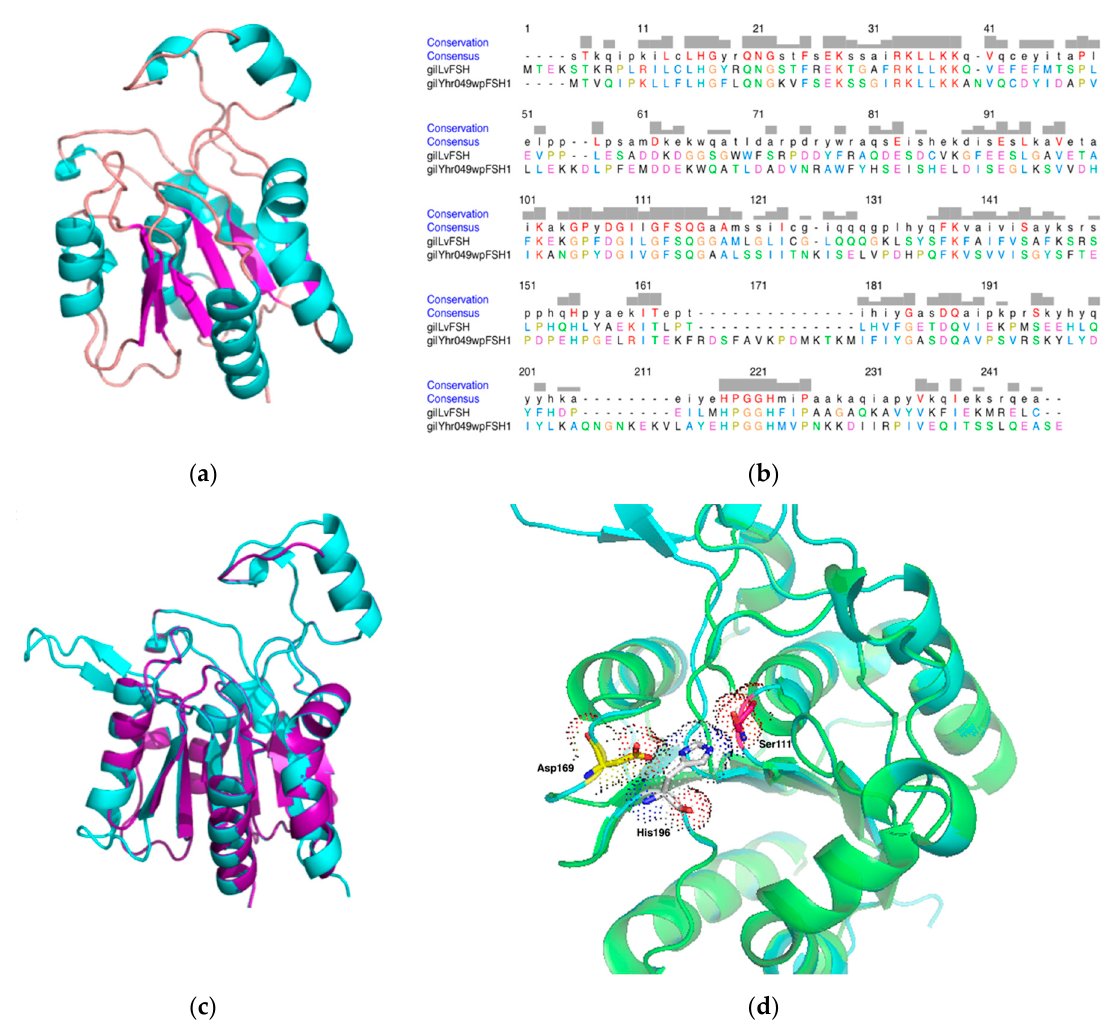
Figure 1. Comparation and analysis of LvFSH model obtain by Phyre2.0 ( a ) Molecular modeling of the structure of Litopenaeus vannamei LvFSH. Ribbon representation helices, strands, and loops are colored ( α -helices cyan, β -sheet magenta, and loops orange, respectively); ( b ) alignment of LvFSH from shrimp (this study) and Yhr049wp ( Saccharomyces cerevisiae ); ( c ) structural alignment of model LvFSH (green) with FSH1 / YHR049W from S. cerevisiae structure (PDB code 1YCD) (cyan); ( d ) putative catalytic triad Ser111 (red), Asp169 (yellow), and His196 (green).